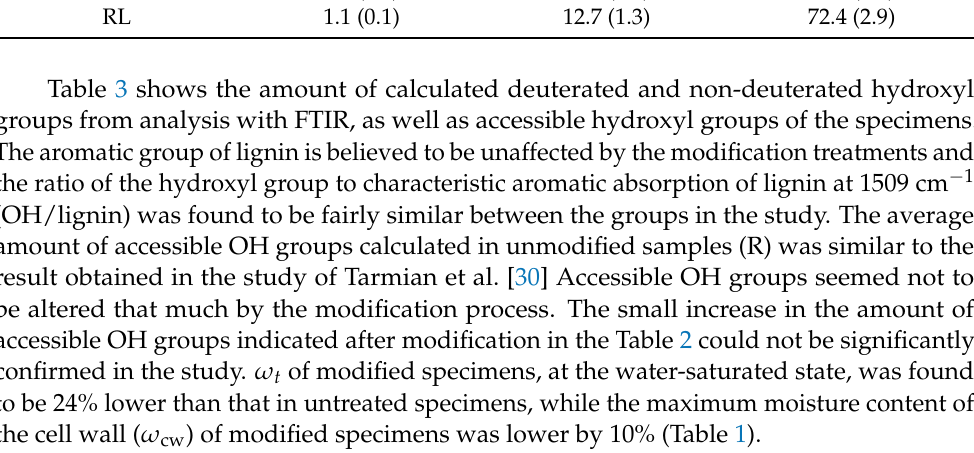
Table 3. Ratio of peak amplitude of hydroxyl group to lignin (OH/lignin) and percentage of accessible hydroxyl group (%) calculated from FTIR data. Values in parenthesis are standard deviation. Sample